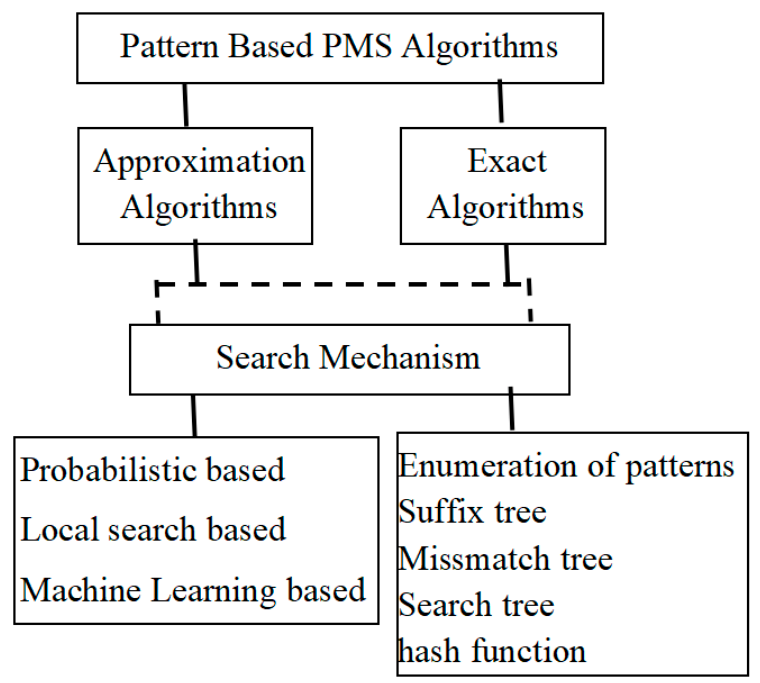
Figure 1. Hierarchy of PMS pattern driven algorithms.